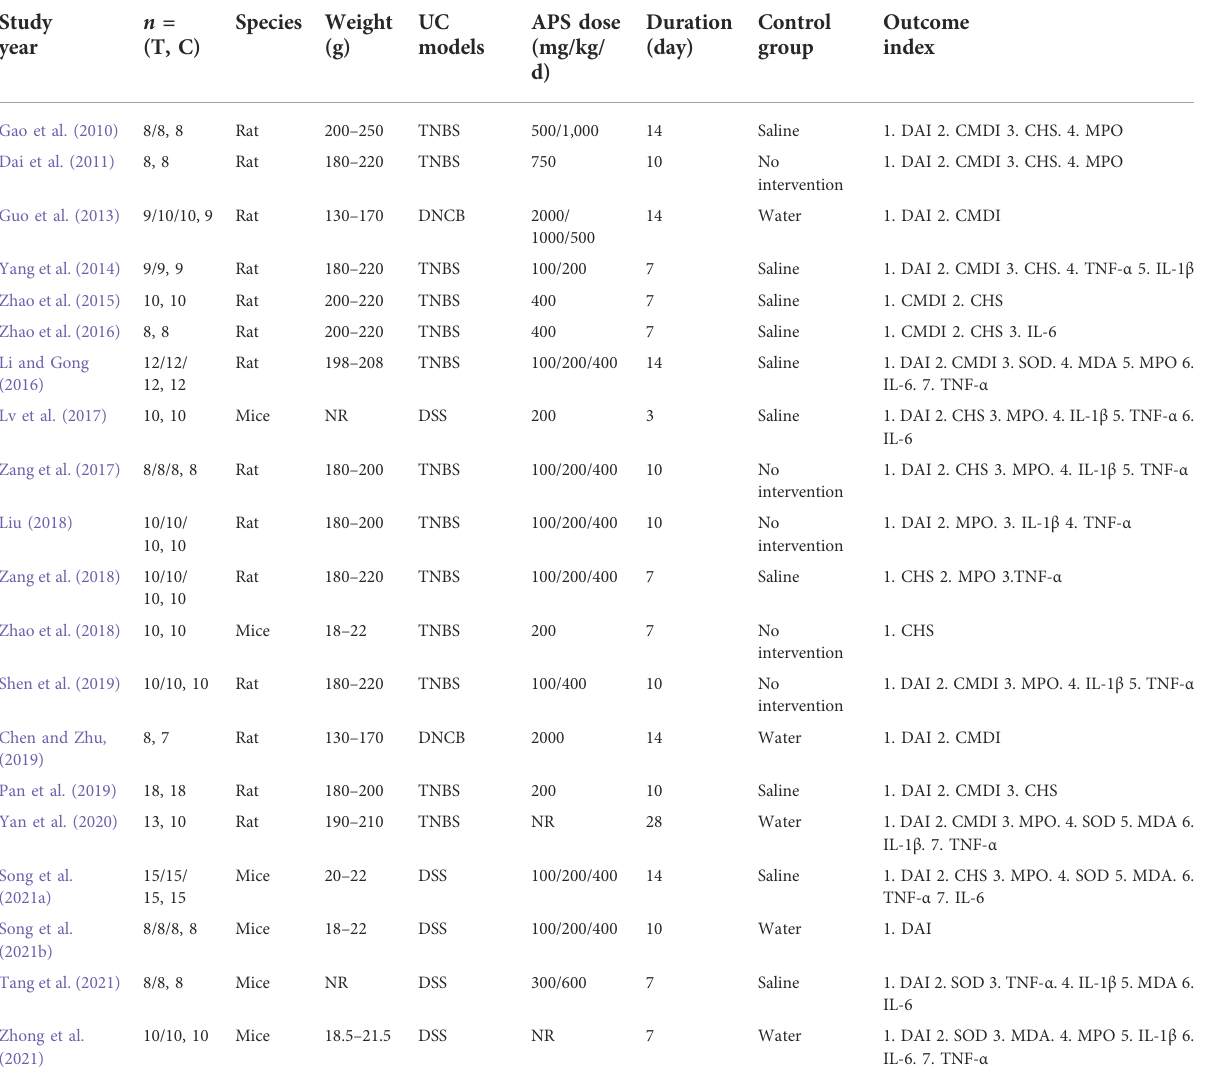
TABLE 1 Characteristics of the included